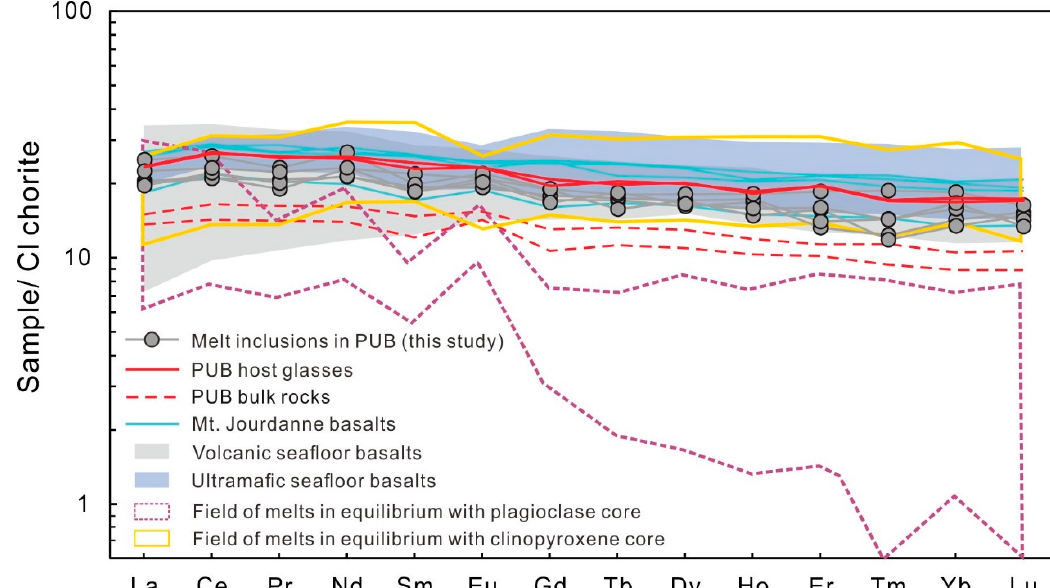
Figure 11. Chondrite-normalized REE concentrations for Mount Jourdanne basalts, PUBs and plagioclase-hosted melt inclusions. The volcanic seafloor basalts and ultramafic seafloor basalts are shown for comparison (as in Figure 4a). Also plotted are melts calculated to be in equilibrium with the plagioclases and clinopyroxene (polygon with purple dashed line and yellow solid line, respectively) in regional plagioclase-rich rock types (i.e., troctolites and gabbros), modified from Paquet et al. [30]. Chondrite normalized values from McDonough and Sun [47].